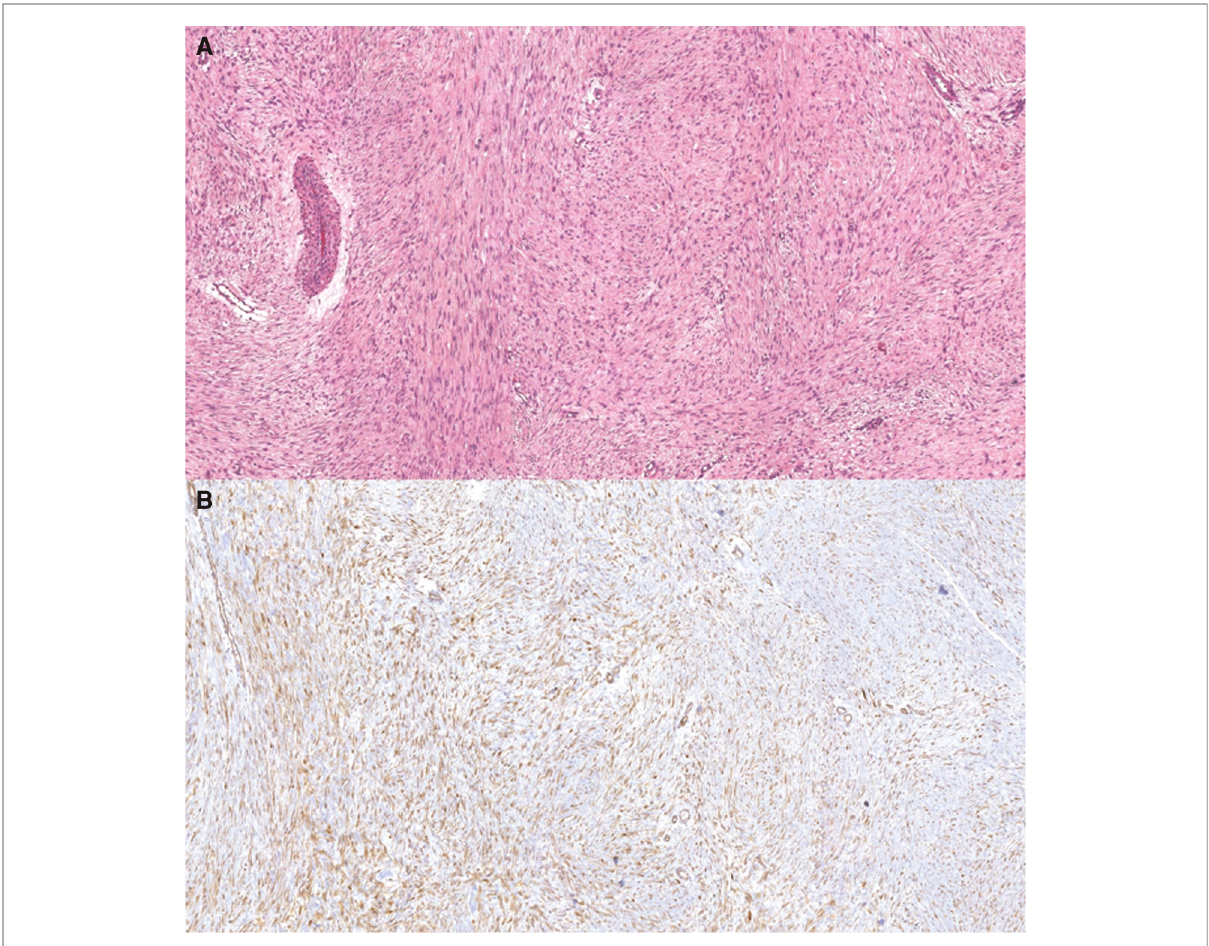
FIGURE 3 Pathological fi ndings of the resected specimen. The tumour cells ( fi broblasts and myo fi broblasts) lack cytological atypia, form long, “ sweeping ” fascicles, and show nuclear beta-catenin expression. These fi ndings are consistent with desmoid fi bromatosis. ( A ) Hematoxylin-eosin, 100×. ( B ) Immunohistochemistry for beta-catenin,